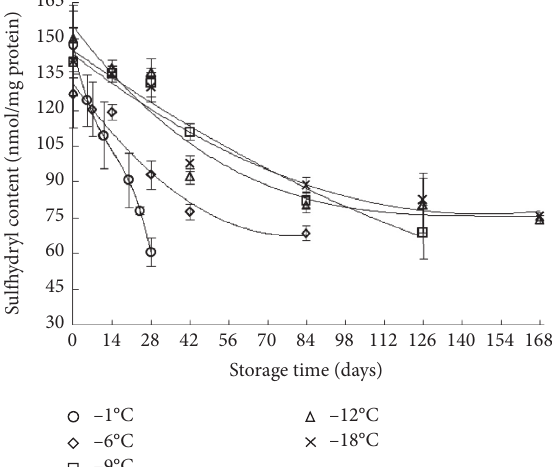
Figure 2: Changes in the carbonyl content of beef MP during storage at − 1, − 6, − 9, − 12, and − 18 ° C.